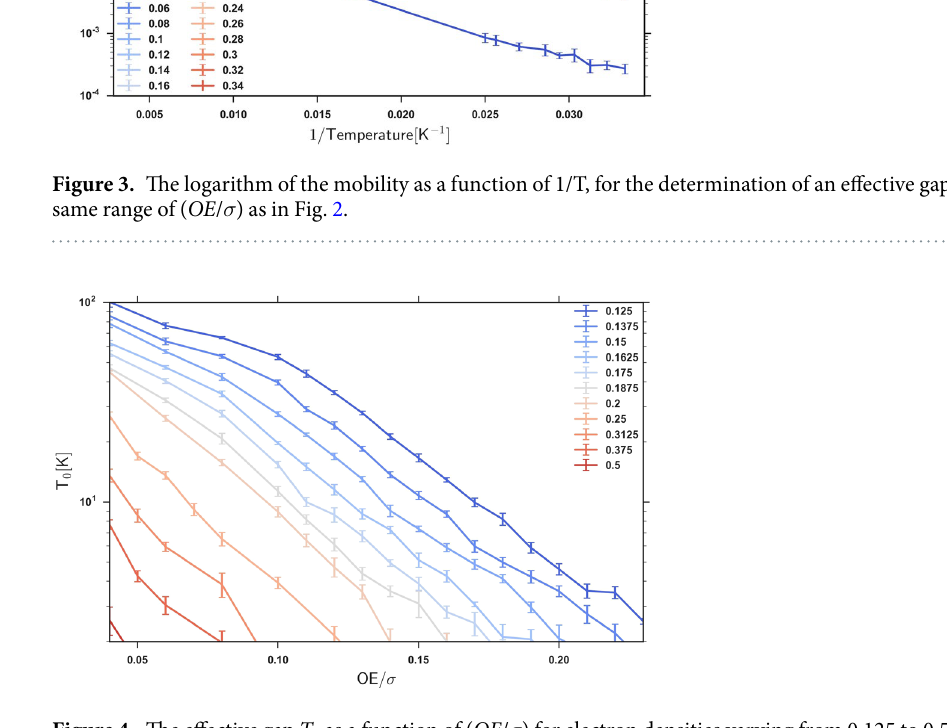
Figure 4. The effective gap T 0 as a function of ( OE / σ ) for electron densities varying from 0.125 to 0.5 electron/